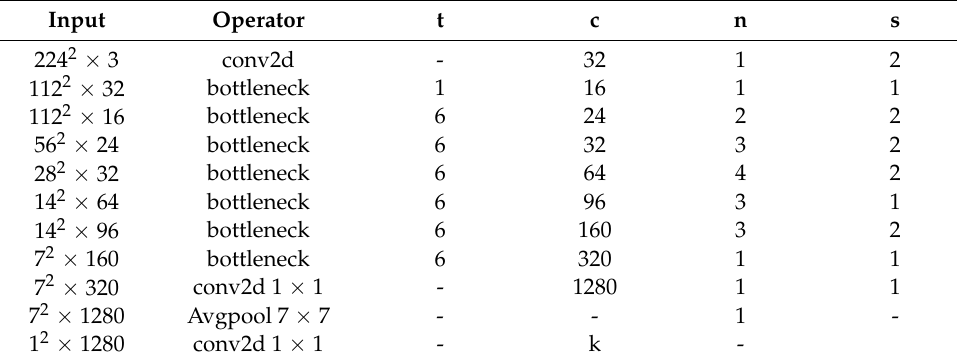
Figure 12. MobileNetv2-YOLOv4 detection process. Table 3. MobileNetv2-YOLOv4 structure.